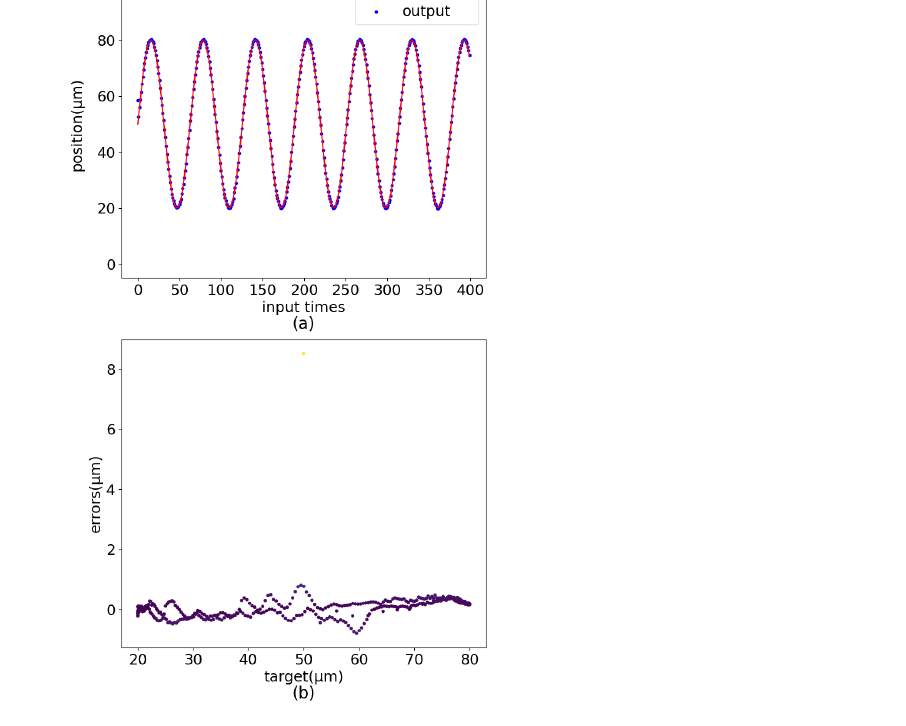
Figure 20. PEA-RNNwithoutResidualConnectioncontrolerrors. ( a )Curvecomparision. ( b )Errordistribution. The role of the residual connection is to speed up the neural network training process. At the same time, it is beneficial to build a deeper network, which can also increase the nonlinear expression ability of the